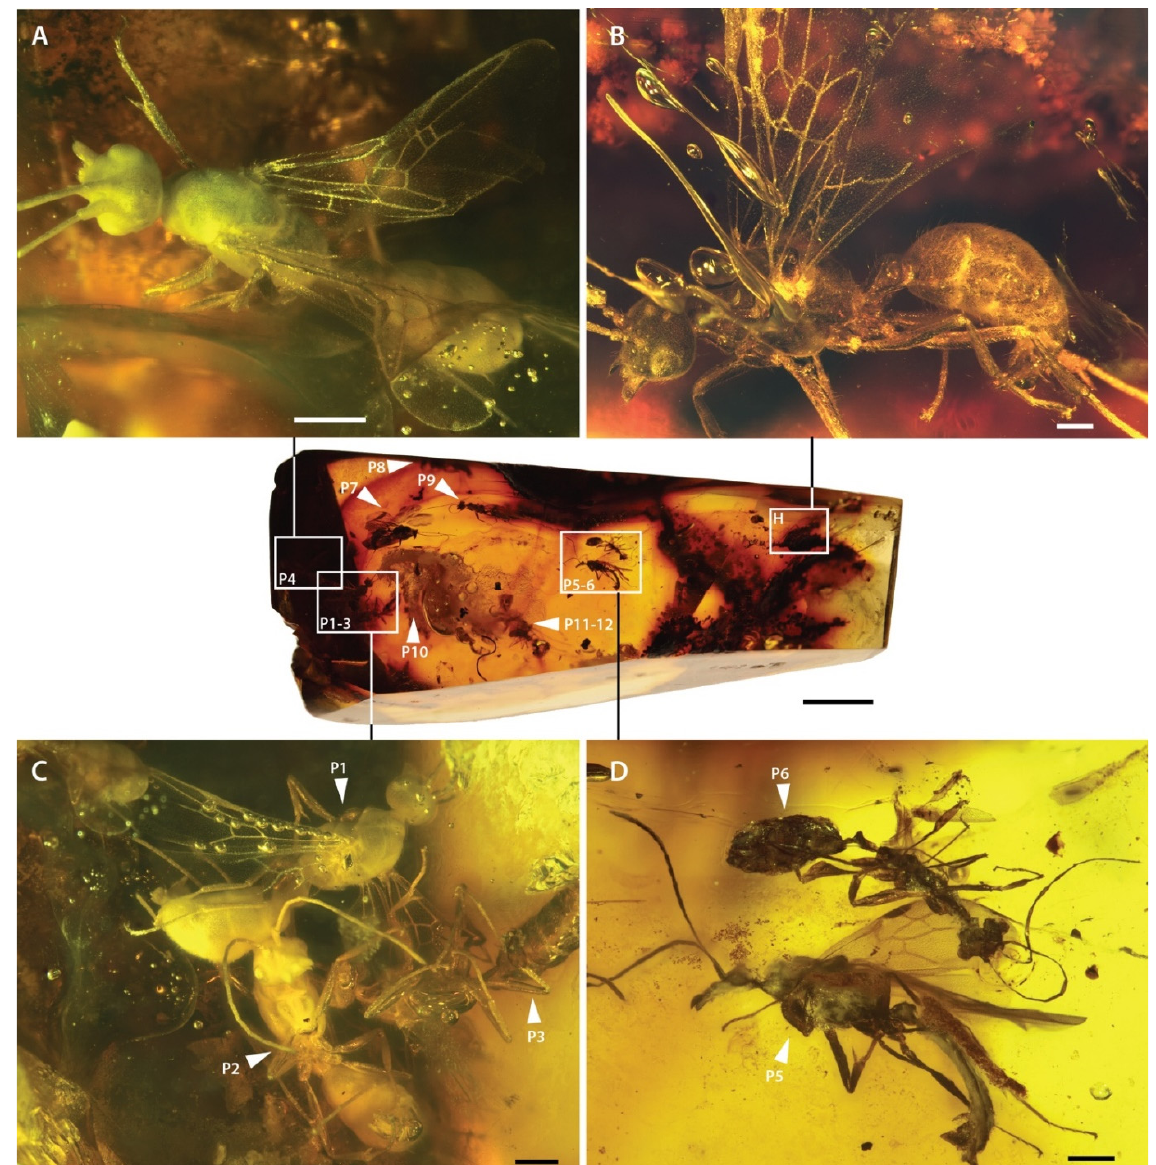
Figure 1. Photograph of entire amber piece MAIG 6016, with indication of type specimens (labeled H for holotype, P1–P12 for paratypes) of † Desyopone hereon gen. et sp. nov., and with detailed views of seven of them ( A – D ). ( A ) paratype 4; ( B ) holotype; ( C ) paratypes 1–3; ( D ) paratypes 5–6. Scale bars: 0.5